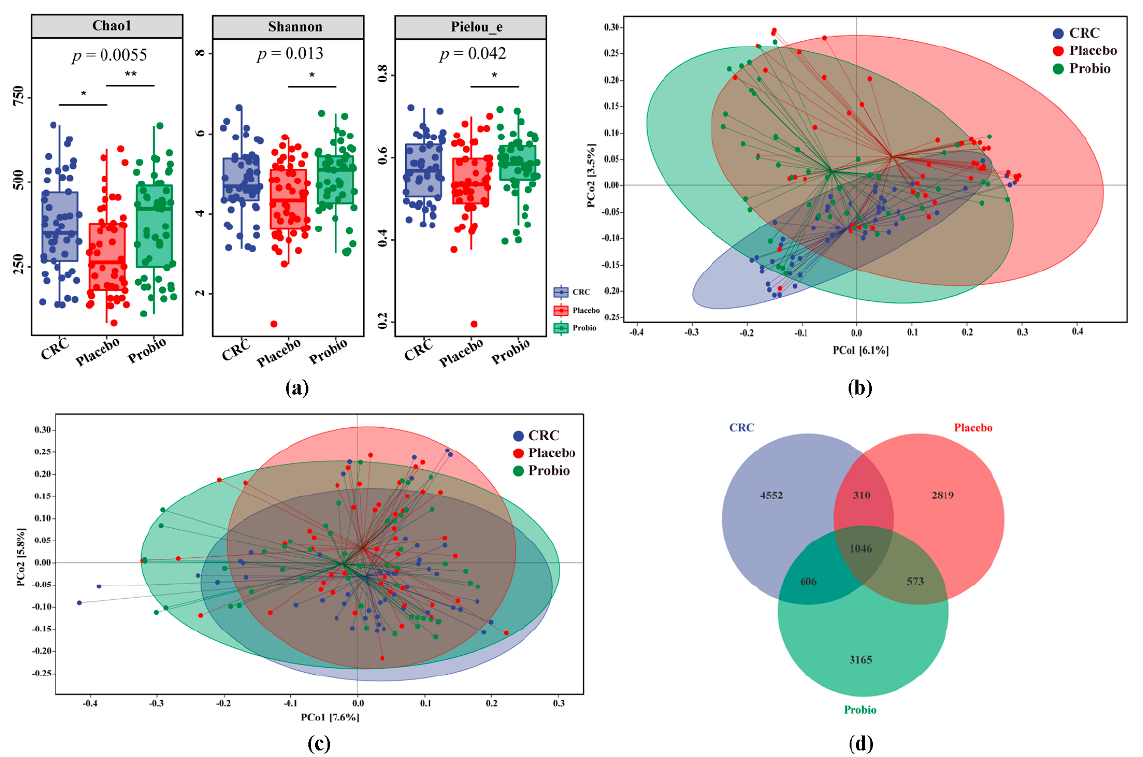
Figure 2. Probiotics combination restored the changed gut bacterial diversity in CRC patients re- ceiving chemotherapy. ( a ) Chao1, Simpson, and Pielou_e (PE) indexes of gut microbial α diversity in the fecal samples among the three groups. ( b , c ) The PCoA analysis of gut microbial β diversity based on Jaccard and Unweighted_unifrac distances, respectively. ( d ) Venn diagram of the identi- fied bacterial species among CRC patients. CRC, the standard reference group before anticancer treatment. Placebo, the control group taking placebo. Probio, the treatment group taking probiotic combination. Multiple comparison analysis based on Kruskal − Wallis test following Dunn’s test, * p < 0.05, ** p < 0.01.